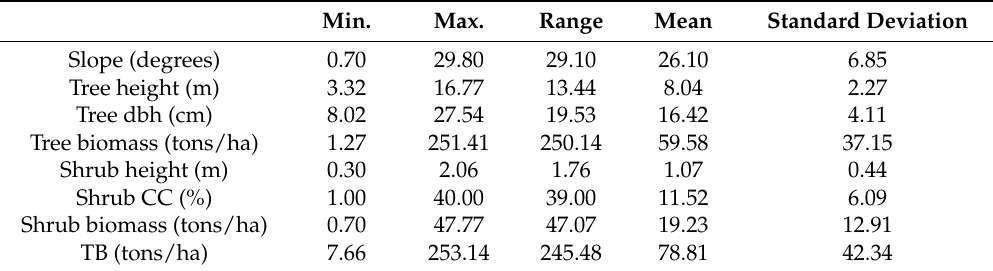
Table 2. Summary of the field plot characteristics ( n = 83). CC is canopy cover; TB is total biomass. Min.